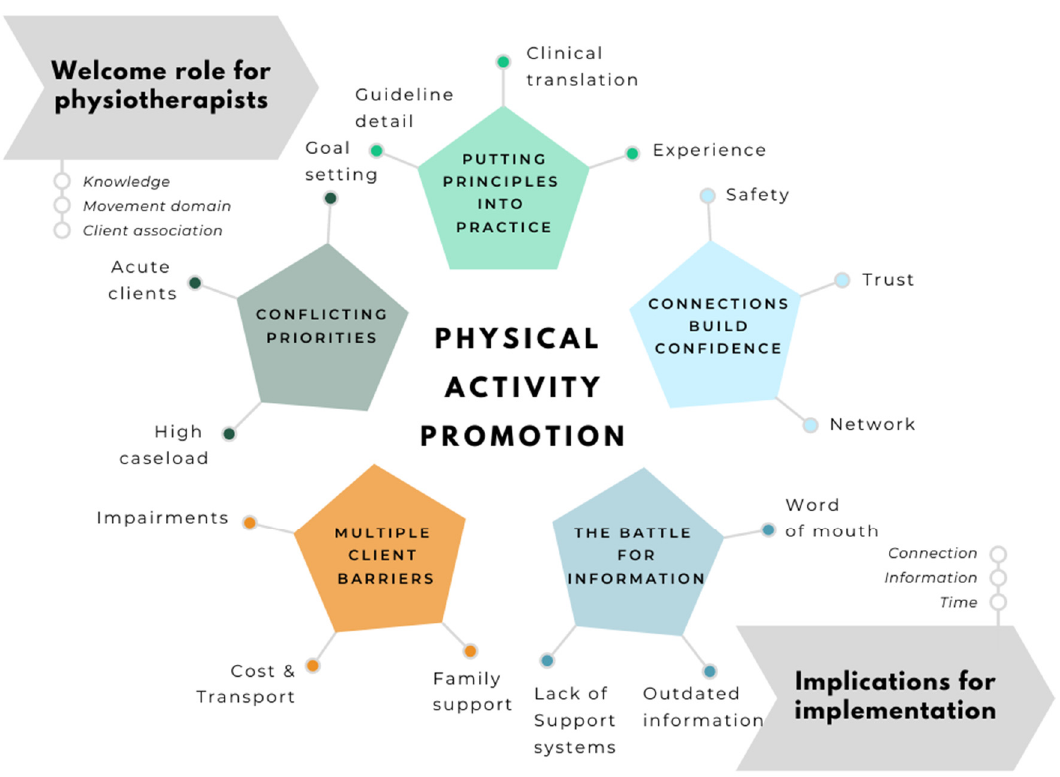
Figure 1. Themes for physiotherapists’ roles in physical activity